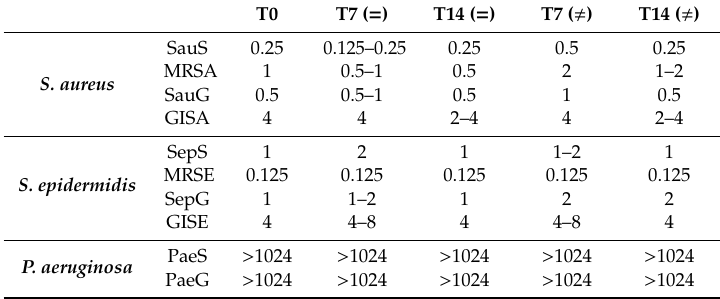
Table 3. Resistance profile of the tested strains to vancomycin before (T0) and after (T7) exposure to CV and after cycle on antibiotic-free medium (T14). Numbers indicate vancomycin concentrations ( µ g / mL). ( = ), exposure to the same CG disc; ( (cid:44) ), exposure to a fresh CV disc. T0 T7 ( = ) T14 ( = ) T7 ( (cid:44) ) T14 ( (cid:44)